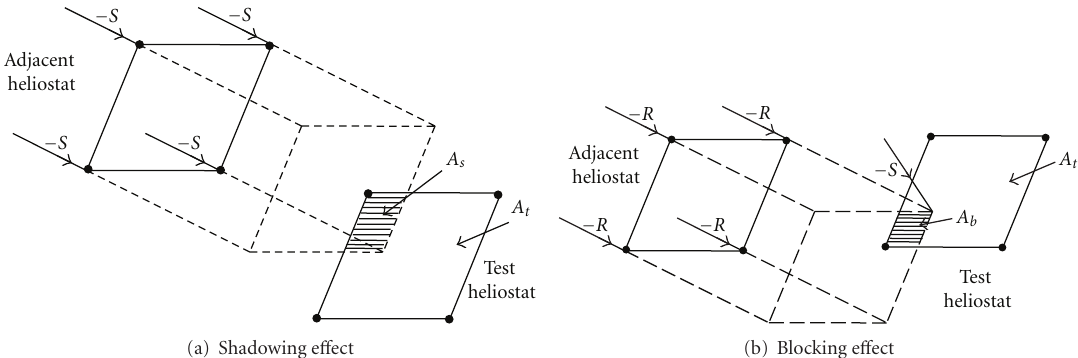
Figure 4: Ray/plane algorithm is used to compute the intersection area which is caused by shadowing and blocking to the “Test Heliostat.” area of the “Adjacent Heliostat” cast on the surface plane that represents the heliostat frame of “Test Heliostat” as illustrated in Figure 4(a). For the blocking e ff ect, the reflected sunray from the “Test Heliostat” is used instead of incident plane of “Test Heliostat” as shown in Figure 4(b).